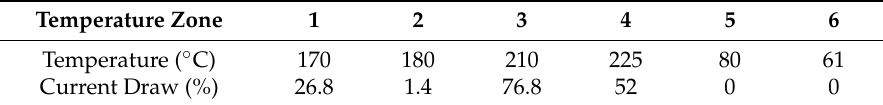
Table 1. Temperature parameters for